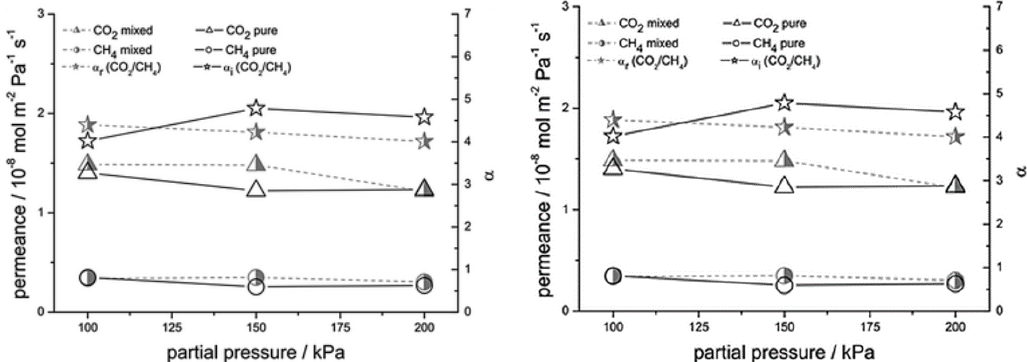
Figure 52. ( Left ) permeance of pure and equimolar mixed CO 2 and CH 4 measured for the [Cu 2 (ndc) 2 (dabco)] n (1) membrane at room temperature (T = 298 K) as a function of pressures at the feed side (total pressures for pure gases, partial pressures for the gas mixture). The ideal and mixed gas separation factors α i and α r were calculated from the corresponding ratio of the CO 2 /CH 4 permeance. ( Right ) permeance of pure and equimolar mixed CO 2 and CH 4 measured for the [Cu 2 (BME-bdc) 2 (dabco)] n (2) membrane at room temperature (T = 298 K) as a function of pressures at the feed side (total pressures for pure gases, partial pressures for the gas mixture). The ideal and mixed gas separation factors α i and α r were calculated from the corresponding ratio of the CO 2 /CH 4 permeance (adapted with permission from ref. [148].